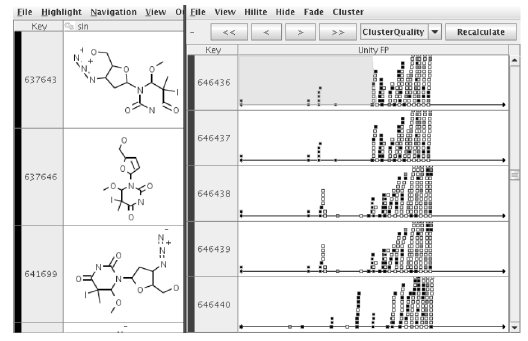
Fig. 15. A fuzzy cluster of the NIH-Aids data centered around compound #646436. This cluster nicely covers part of one of the most well-known classes of active compounds: Azido